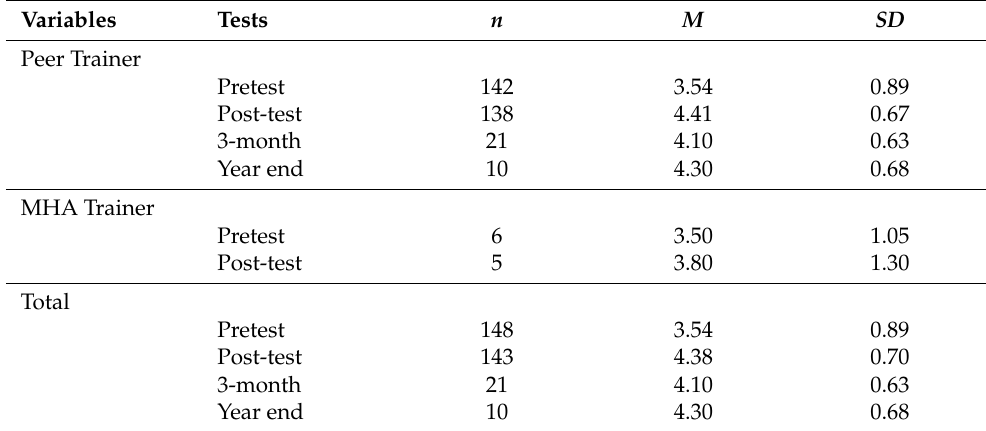
Table 2. Perceptions of trauma’s effects on learning ( n =